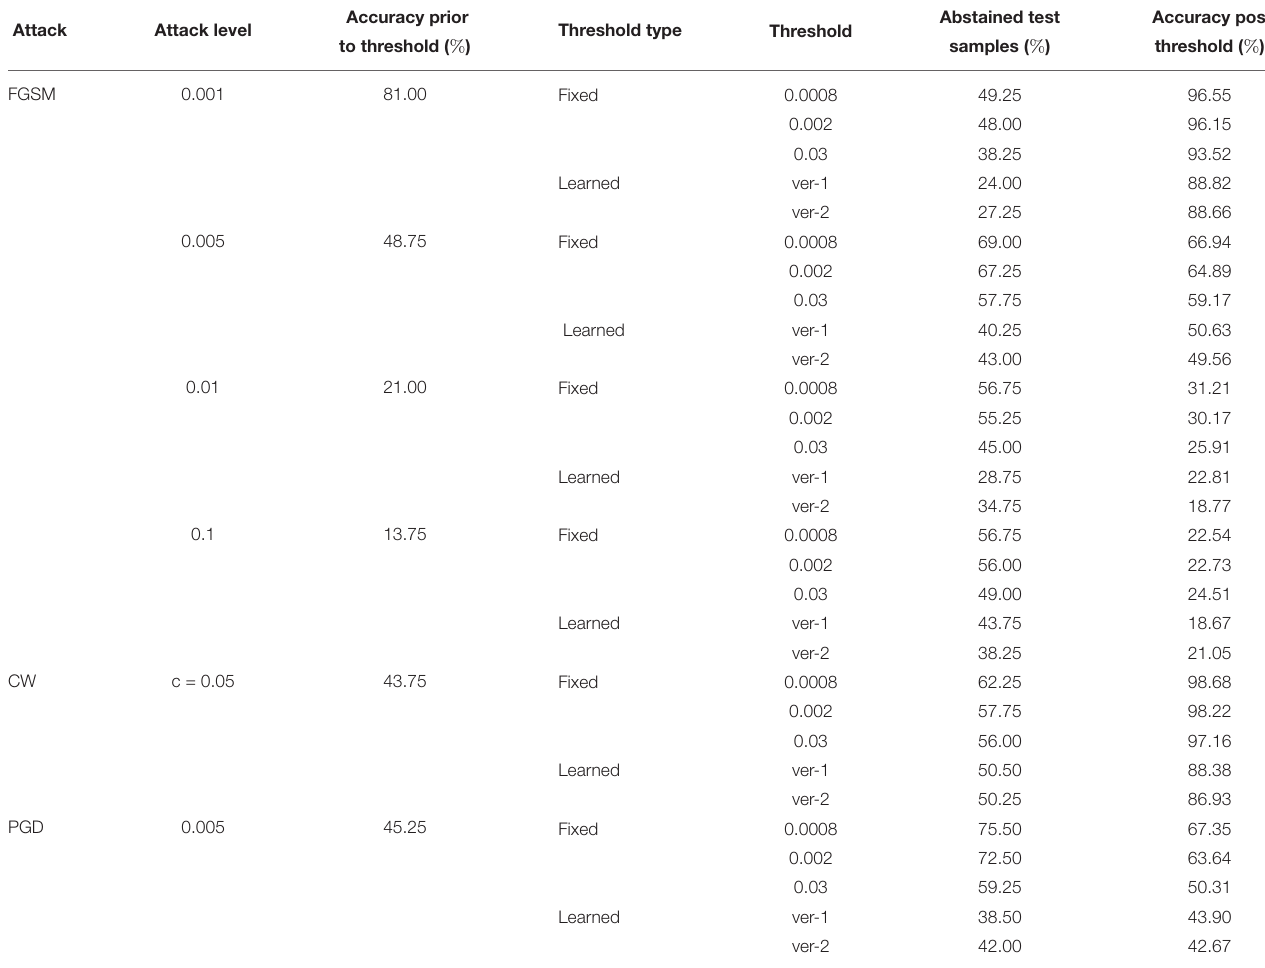
TABLE 8 | Detection of failure in BDNNs—PathMNIST dataset tested under various types of adversarial attacks.